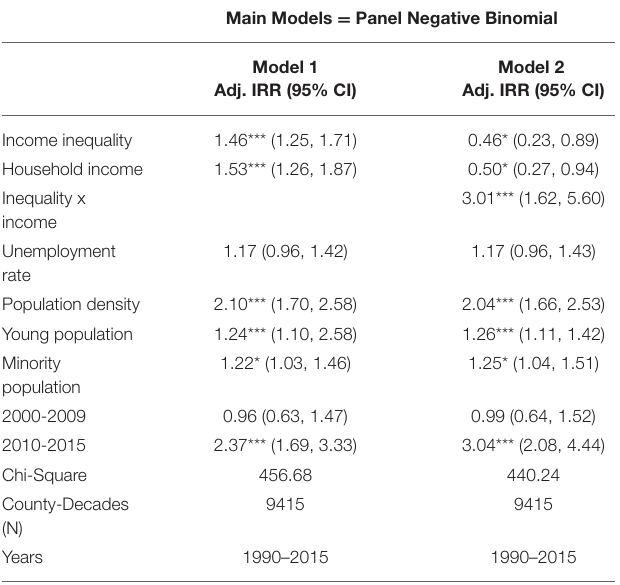
TABLE 1 | Incidence rate ratios of mass shootings in U.S. counties.